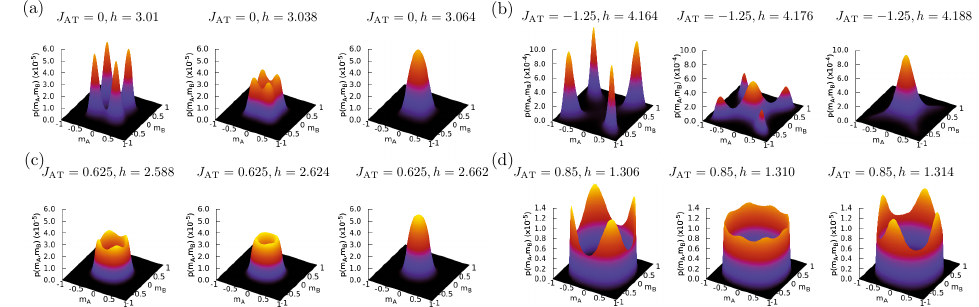
) for paths through different Figure 3: Sublattice magnetization histograms P ( m , m A B types of phase transitions. For each path, we fix J and vary h to cross the transition. AT The left and right panels show the histograms within the corresponding phases, the central panels are very close to the phase transition point. For all plots L = 32 except for (b) where L = 16 is shown. (a) Ising 2 transition from the FM phase to the PM = 0. The central panel shows that the four peaks (FM) smoothly trans- phase for J AT form into a single peak (PM), illustrating the continuous Ising 2 nature of the critical / J = − 1.25. point. (b) First order transition between the FM and the PM phase for J AT The central panel shows phase coexistence of the two phases where the four peaks at the diagonal (FM) are equally present with the center peak (PM). (c) XY / O(2) / J = 0.625. Around the critical point transition from the FM to the PM phase for J AT (central panel) the histogram becomes rotationally symmetric illustrating the emer- gent O(2) symmetry of the critical point. (d) (Weakly) first order transition between / J = 0.85. The central panel shows that the abso- the FM and the 〈 µ 〉 phase for J AT 〉 is finite at the transition. The distinct four plus four peaks lute magnetization 〈 m S characteristic for both phases are weak, but equally